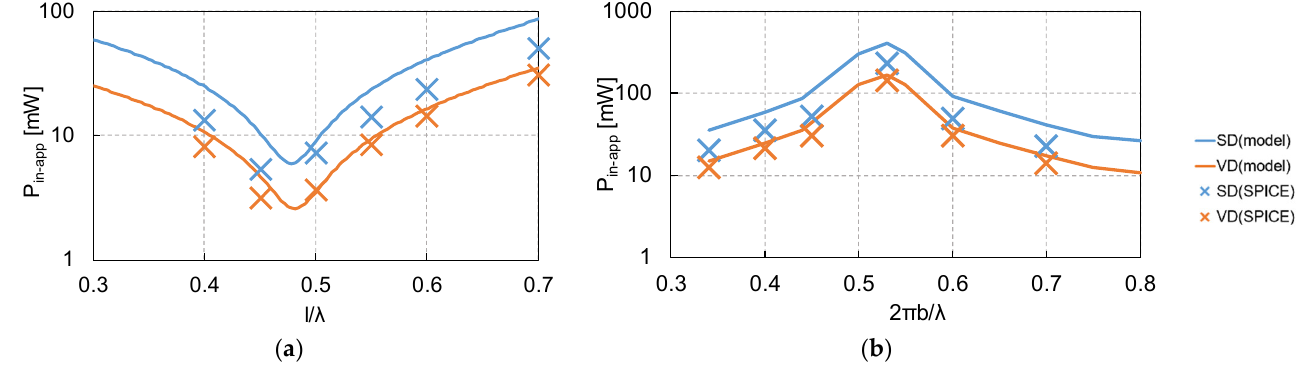
Figure 16. Antenna parameter vs. P in − app based on model 2 at P out = 100 µ W ( 1 V, 100 µ A ) : ( a ) dipole antenna, ( b ) circular loop